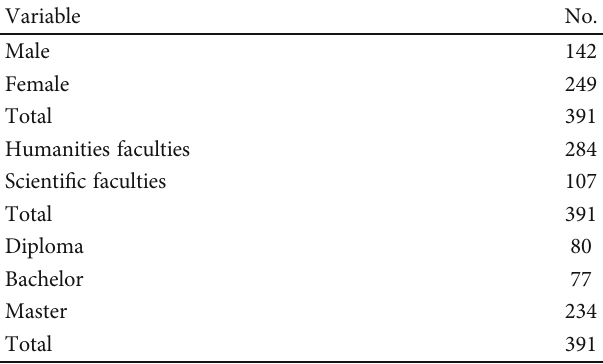
Table 1: Study sample according to the demographic variable.